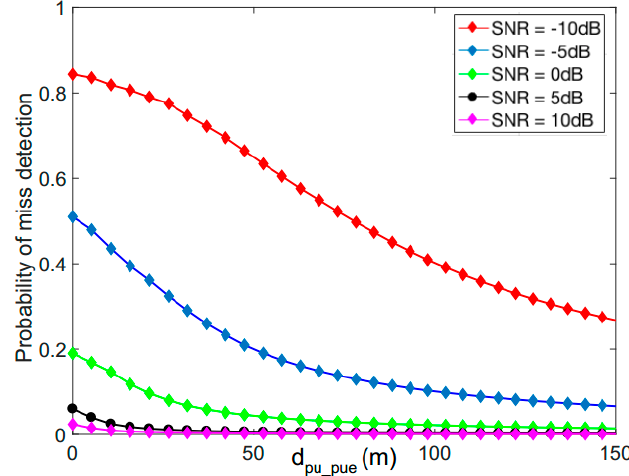
Figure 7. Probability of miss detection as a function of the distance d PU_PUE between the mobile PU and a PUE.